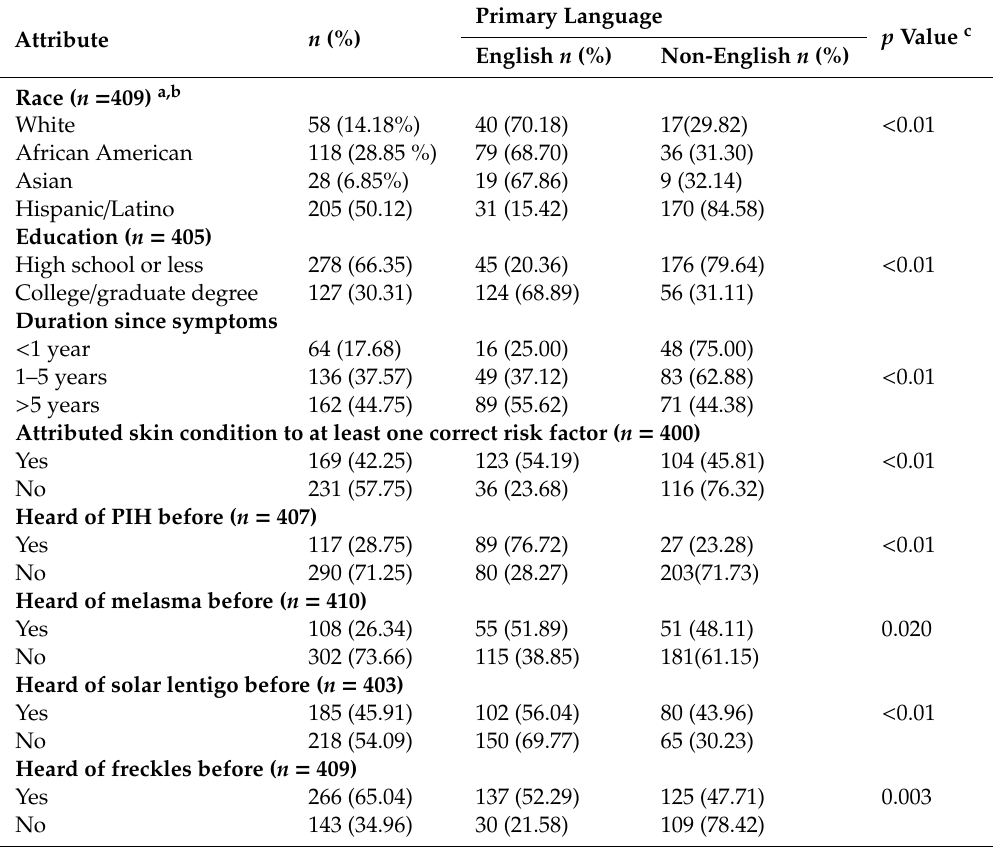
Table 3. Clinical Characteristic of the study